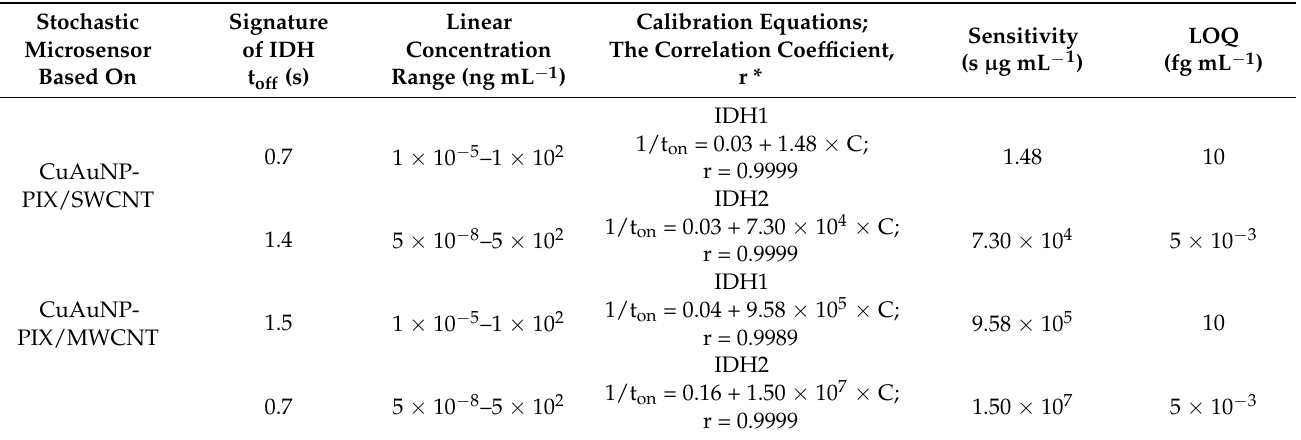
Table 1. The response characteristics of the stochastic microsensors used for the molecular recognition of IDH1 and